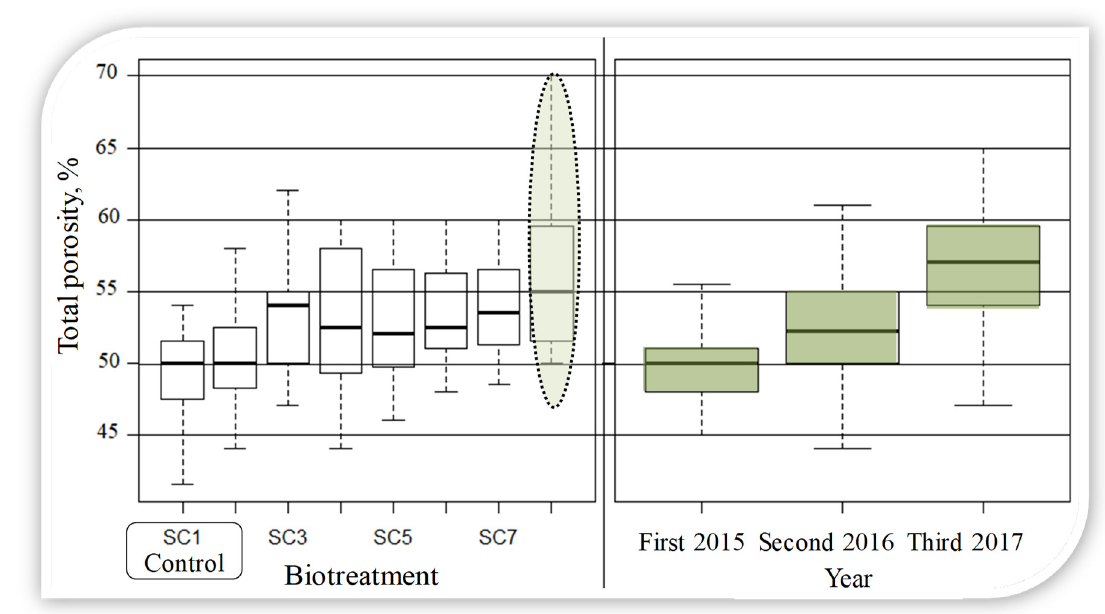
Figure 7. Total porosity of soil (%) dependence on bio-impact time (year) and scenario. The humus average change over 2015–2017, compared with that in 2015 and 2017, only showed an increase in SC2 (0.15). The highest value of humus was in SC6 in 2015, in SC7 in 2016, and in SC1 in 2017. Humus values differed significantly by year ( p < 0.000), and the differences among the scenarios were not significant. The largest decrease was observed in SC6 (1.95%) (Figure 8).